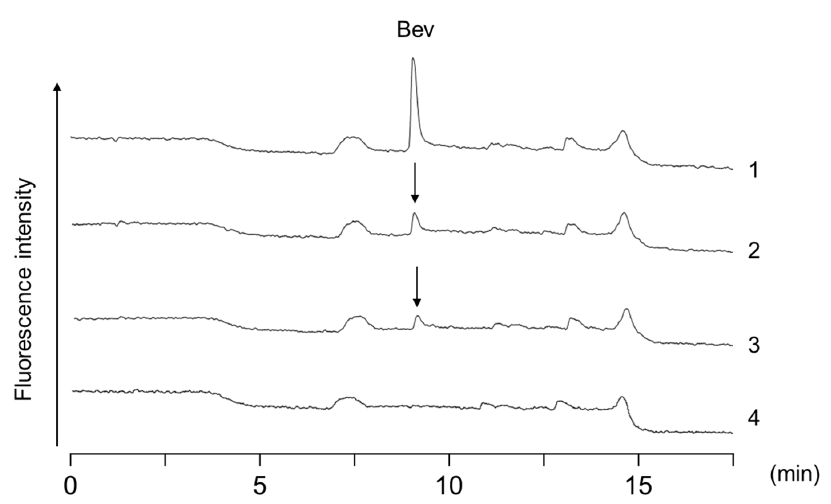
Figure 2. Chromatograms of residual solution when 100 µ L of a 50 µ g/mL bevacizumab standard solution was captured on the three types of aptamer affinity beads. Chromatograms: 1. bevacizumab standard solution; 2. tosylactivated beads; 3. carboxylic acid beads; 4. streptavidin beads. Peak: Bev: bevacizumab.